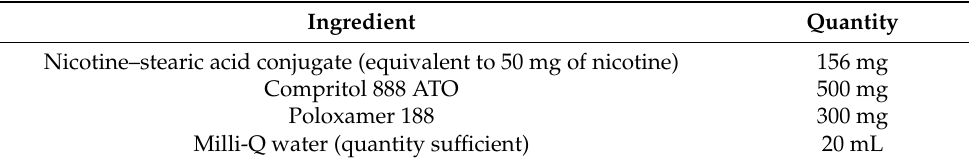
Table 3. Formula for Nicotine–stearic acid conjugate-loaded SLNs. Ingredient